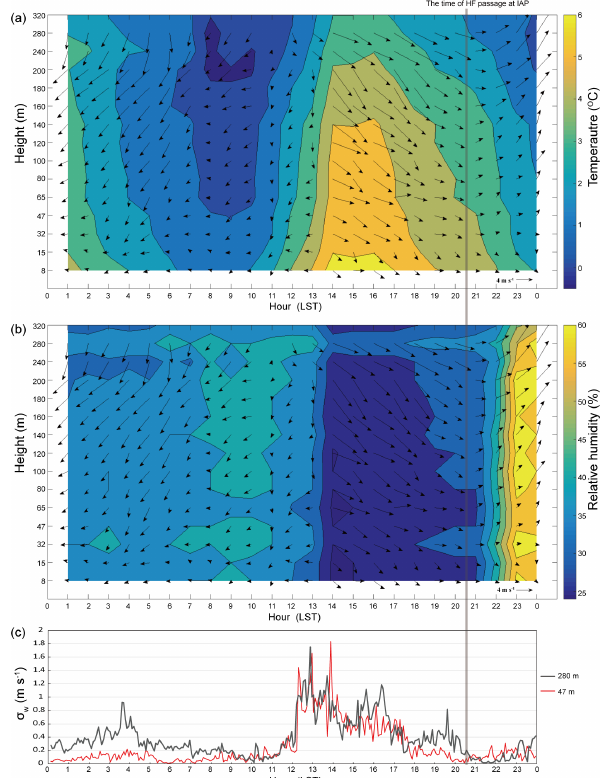
Figure 10. Temporal variations of (a) temperature (colored con- tours) and wind vectors, (b) relative humidity (colored contours) and wind vectors at 15 levels on the IAP tower, and (c) vertical velocity standard deviation at 47 and 280m on the IAP tower on 24 December 2015. The gray line indicates the time of HF passage at